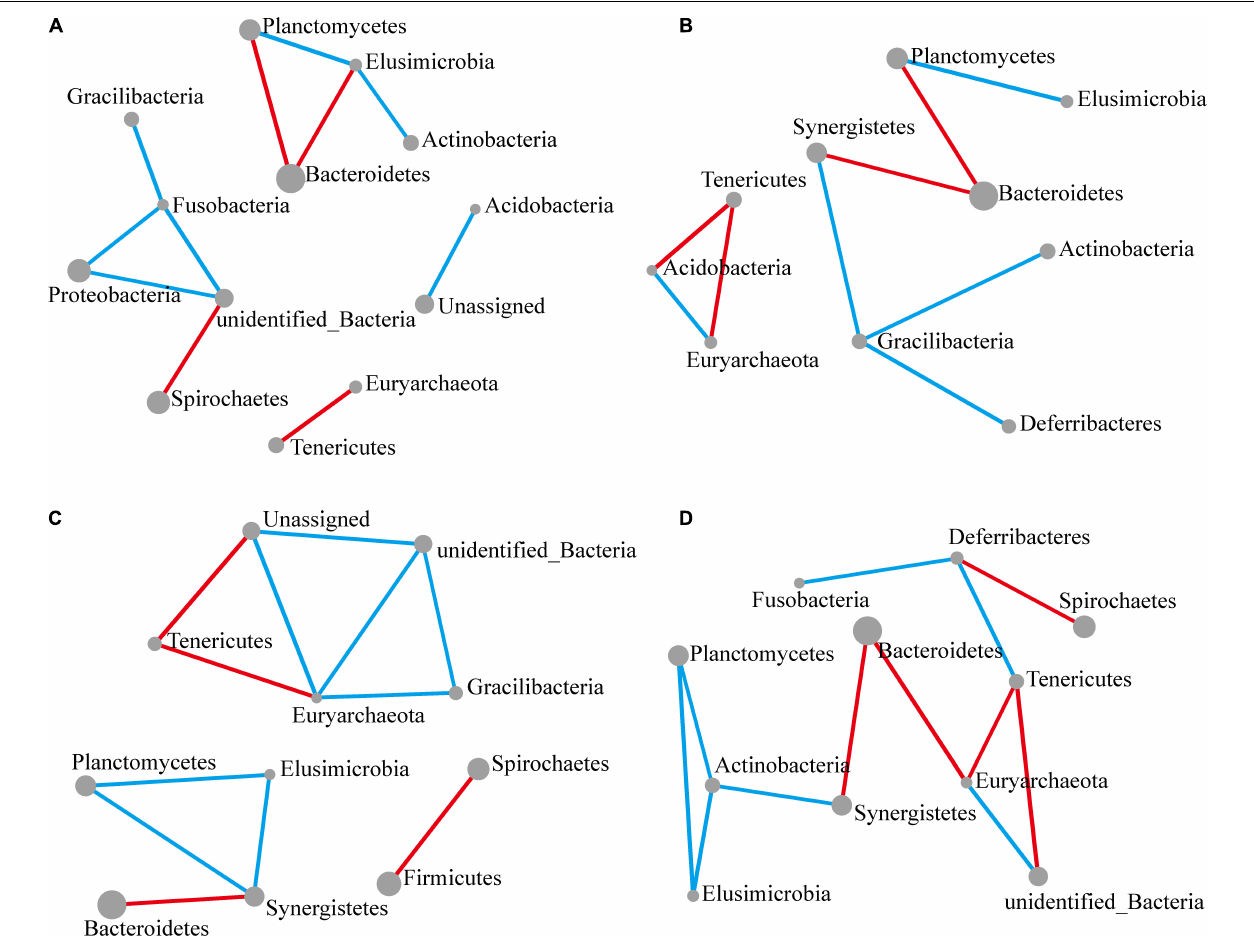
FIGURE 4 | Significant changes in interactions at the phylum level. The size of each node reflects the abundance of each phylum, while the width of each line connecting two nodes corresponds to the strength of the interaction between the phyla representing each node. A blue line indicates that interactions were positive, while a red line indicates that interactions were negative. In all cases, the control group was used as a comparison and Pearson’s product-moment correlation was used to determine interaction strength ( P -value ≤ 0.05). (A–D) Network diagram showing interactions at the phylum level, respectively, at 12 (A) , 24 (B) , 48 (C) , and 72 h (D) following M. robertsii